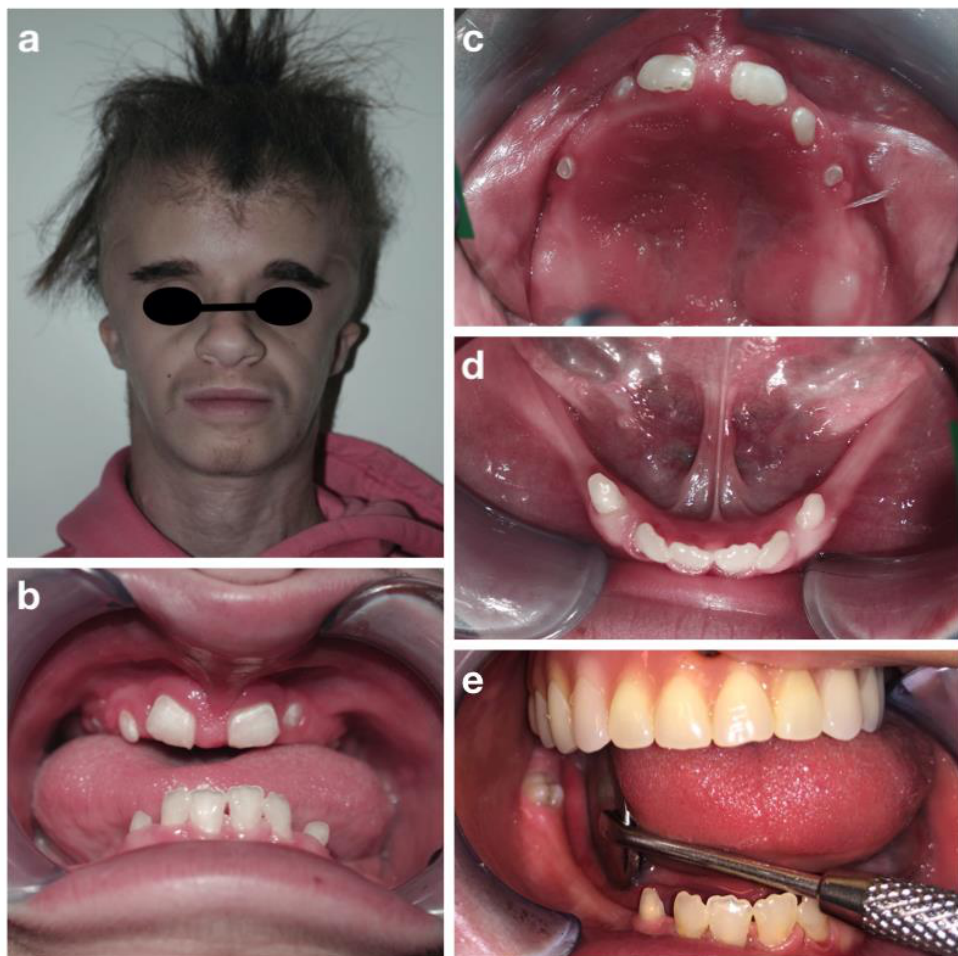
Figure 9. Progeroid syndrome: extra-oral ( a ), intra-oral ( b – e ) pictures at the follow-up visit at the age of 12 years.